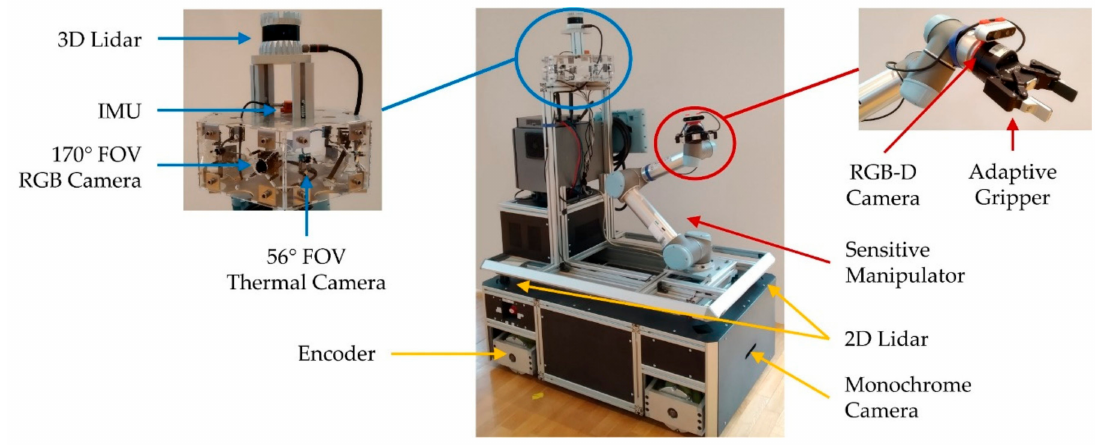
Figure 3. Sensor setup of the mobile manipulator